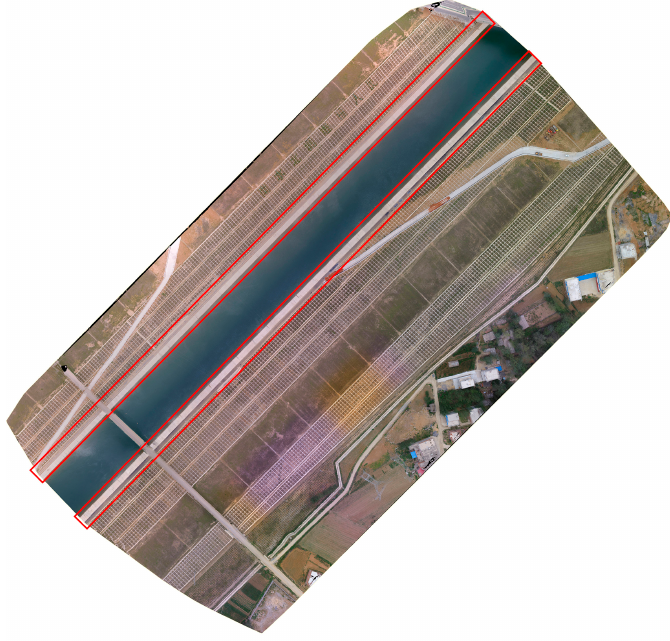
Figure 10. Overall concrete slope protection project.